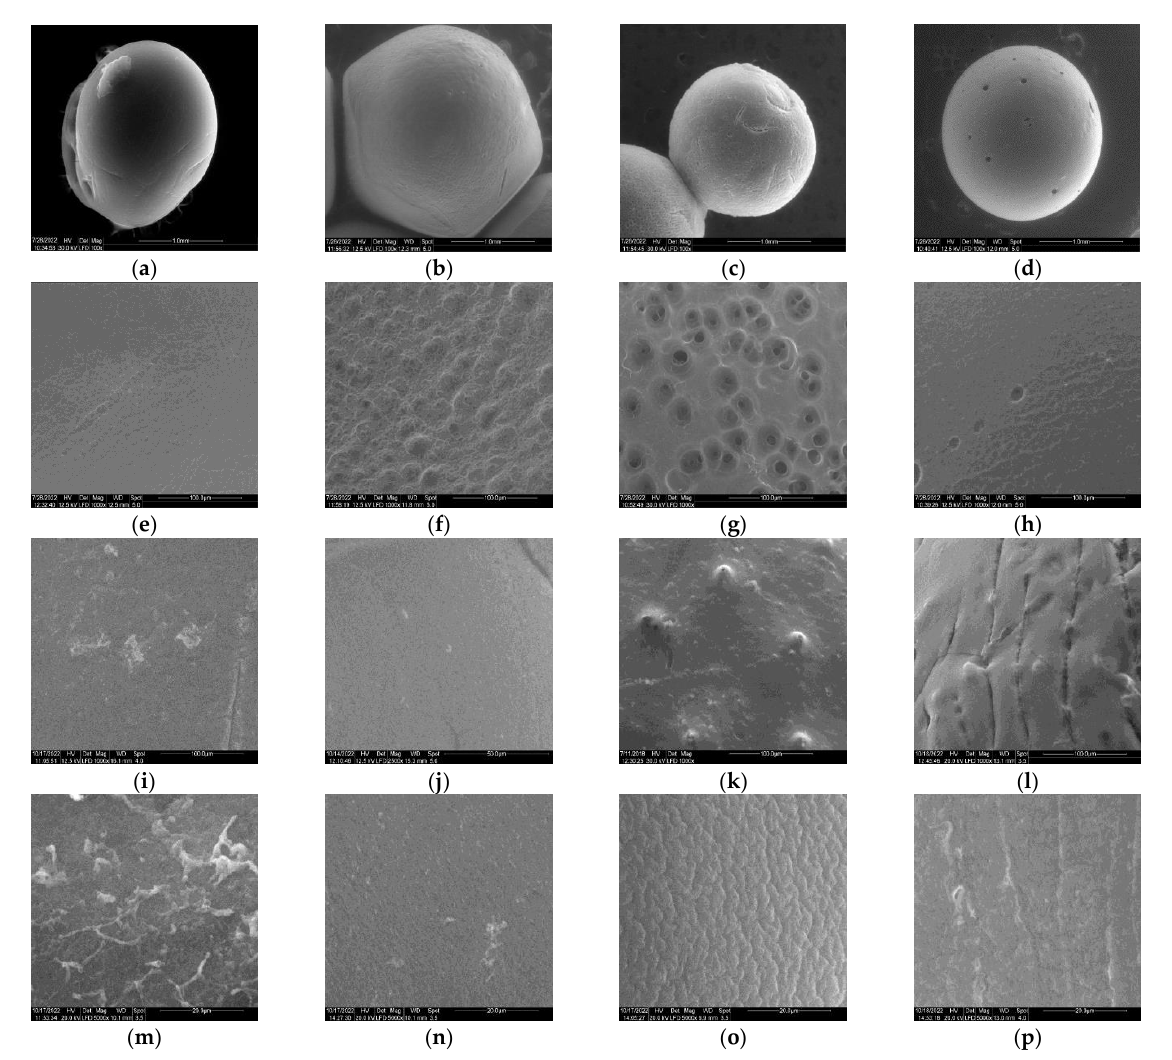
Figure 1. ESEM images of microspheres — ( a ) LCS, (b) MCS, ( c ) LCSPAA, ( d ) MCSPAA; their sur- faces before immobilization — ( e ) LCS, ( f ) MCS, ( g ) LCSPAA, ( h ) MCSPAA; after Ga treatment — ( i ) before immobilization—( e ) LCS, ( f ) MCS, ( g ) LCSPAA, ( h ) MCSPAA; after Ga treatment—( i ) LCSGa, LCSGa, ( j ) MCSGa, ( k ) LCSPAAGa, ( l ) MCSPAAGa; and after Lc immobilization — ( m ) LCSLc, ( n ) MCSLc, ( o ) LCSPAALc, ( p ) MCSPAALc. ( j ) MCSGa, ( k ) LCSPAAGa, ( l ) MCSPAAGa; and after Lc immobilization—( m ) LCSLc, ( n ) MCSLc, ( o ) LCSPAALc, ( p ) MCSPAALc.